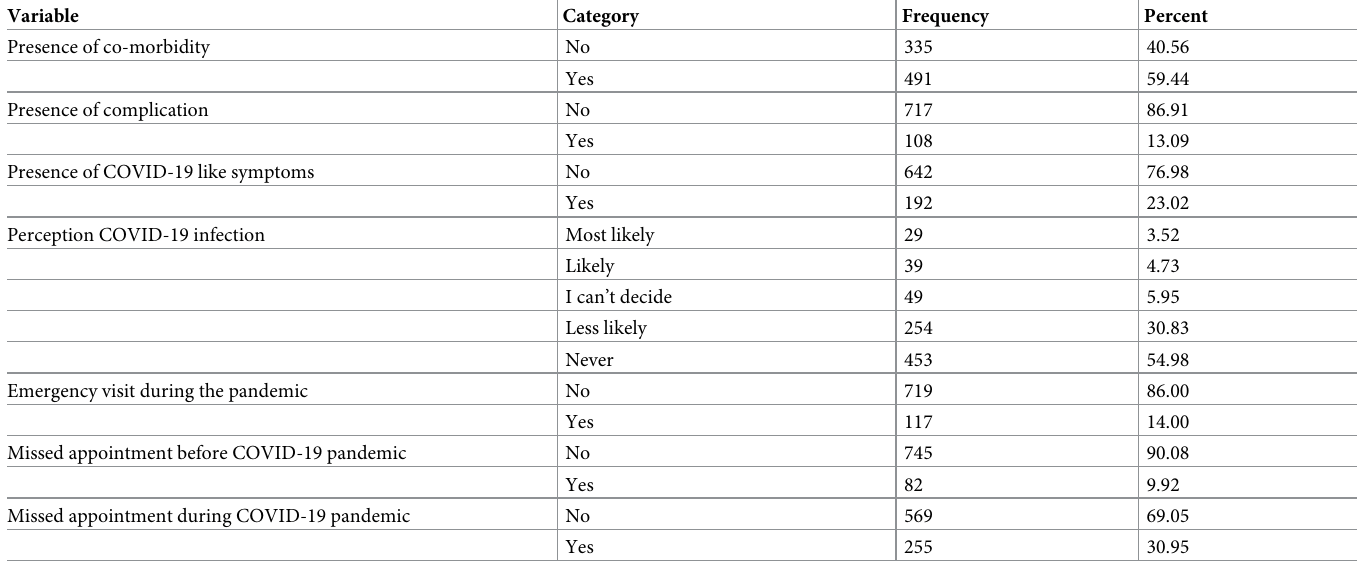
Magnitudes of poor treatment outcome